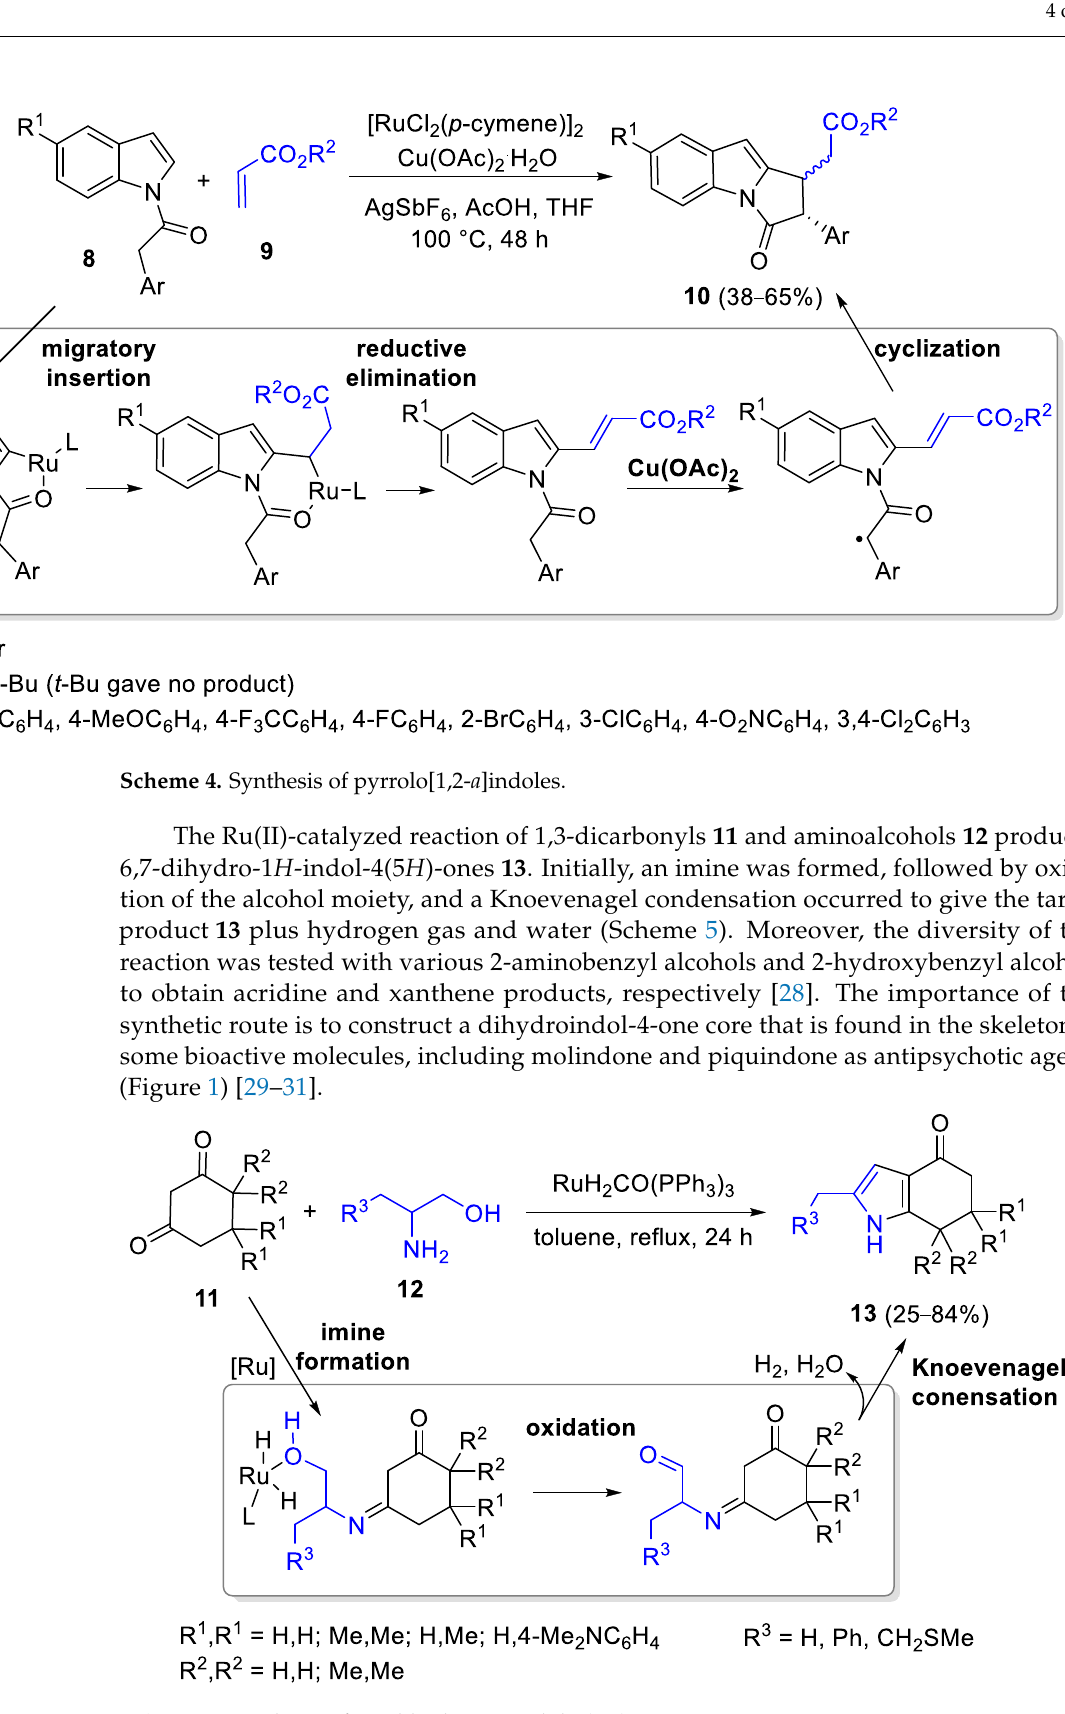
Figure 1 . The structure of molindone and piquindone . 2.2. Isoindole Backbone Synthesis The Ru(II)-catalyzed reaction between 2-arylbenzimidazoles 14 and acrylates 9 gen- erated benzoimidazoisoindoles 15 in moderate to high yields. Running this reaction with 2-heteroarylbenzimidazoles failed the annulation, affording olefin-substituted products (Scheme 6). Moreover, the presence of halogen, as R 1 , at the 5-position of benzimidazole ring 14 led to the formation of regioselective products, while 5-nitro, 5-carboxylate, or 5- methyl (R 1 ) functionalized benzimidazoles resulted in the formation of a mixture of prod- ucts due to the extended resonance [32]. The use of alkynes will fuse a six-membered ring to the imidazole moiety. Zheng et al. could react phenanthroimidazoles with alkynes in the presence of a Rh catalyst to obtain a π -extended product [33].